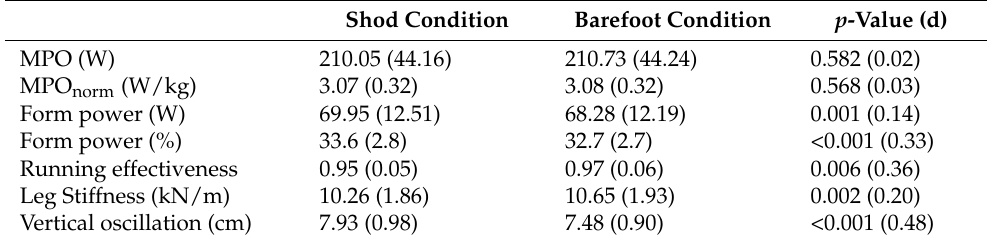
Table 2. Power output and related parameters during running shod and barefoot at comfortable